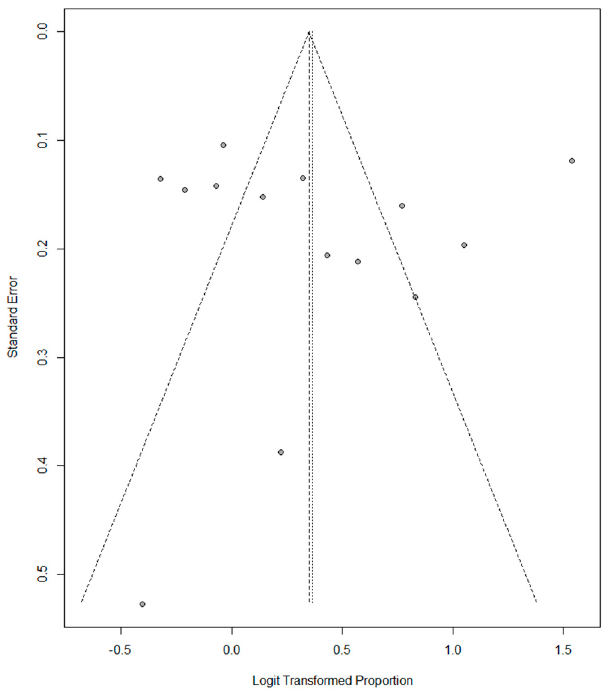
Figure 7. Funnel plot of Vitamin D insufficiency in childbearing-aged women.